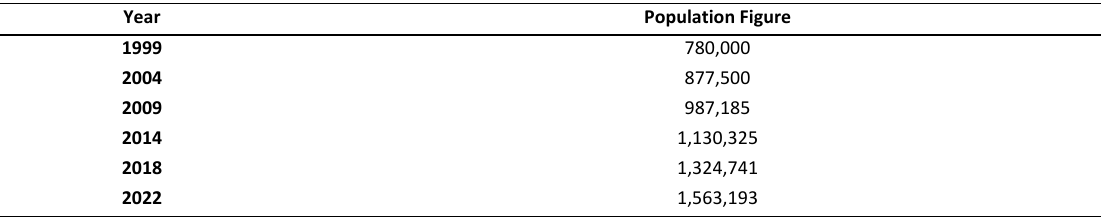
Table 3: Population data of Jos Metropolis